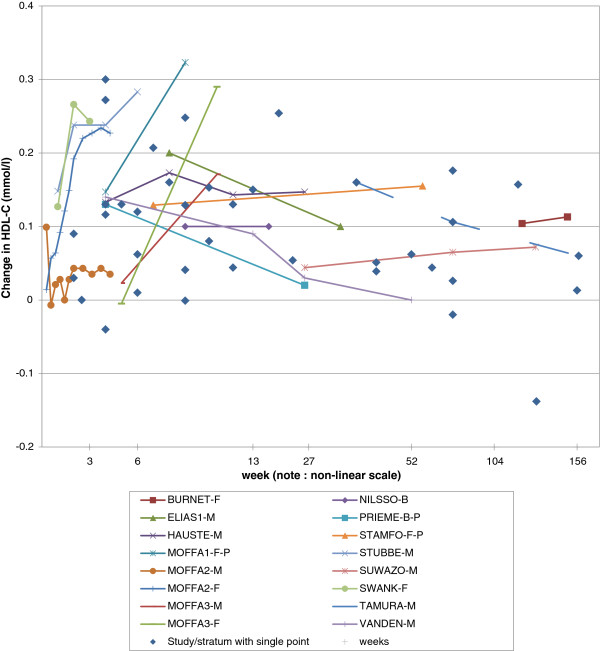
Change in HDL-C by time since quitting. The data are also shown in Additional file 2 (Table A2-1). Independent estimates for different times from study TAMURA are joined by a dashed line. Non-independent estimates for different times from other studies are joined by solid lines and distinguished by symbol and colour, as shown in the figure legend. Where there is a single estimate for a study/stratum, this is shown as a blue diamond: Week 2 FEHER-B, QUENSE-M, PULS-B. Week 4 FERRAR-F, KONDO-M, MOFFA1-F-R, NORREG-B, PRIEME-B-R. Week 5 RICHAR-B. Week 6 ALLEN-B, MASARE-M, MASARE-F. Week 7 STAMFO-F-R. Week 8 ELIAS2-B. Week 9 BASLER-B, LEE-M, NIAURA-F-E, NIAURA-F-C. Week 10 RABKIN-M, RABKIN-F. Week 12, KORHON-F, TONSTA-B. Week 13 LUDVIK-B. Week 19 ZHANG-M. Week 23 TERRES-B. Week 44 YOON-M-L, YOON-M-H. Week 52 GEPNER-B. Week 65 GREEN-M. Week 78, FORTMA-B, RAHILL-M, YEH-B. Week 119 SHENNA-M. Week 130 KUSHIM-M. Week 156 GERACE-M. Note that each individual independent point and the start of each group of non-independent points effectively joins back to the (0,0) point, but this is not shown in the Figure for clarity. Note also that the scale on the x-axis is non-linear (with distances between 13 and 52 weeks reduced to a quarter, and over 52 weeks to a tenth). Abbreviations: B = both sexes, F = females, M = males; L=low weight gain (<1.3 kg), H=high weight gain (≥1.3 kg); P = persistent quitter, R = resumed smoking before end of study; E = exercise training intervention, C = control group.